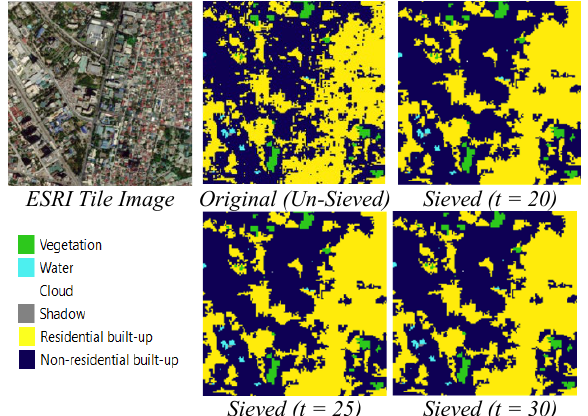
Figure 11. Original and sieved outputs (Level 2 best output)